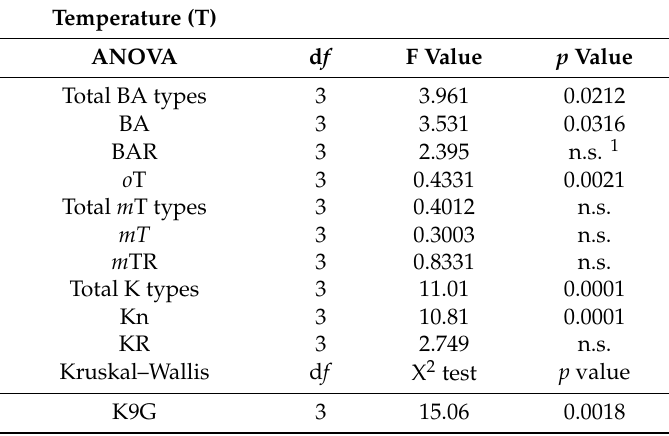
Table 7. One-way analysis of variance for concentration of endogenous aromatic cytokinins (pmol g −1 FW) detected in P. halepensis embryonal masses induced under different temperatures (23 °C, 9 weeks; 40 °C, 4 h; 50 °C, 30 min; 60 °C, 5 min).